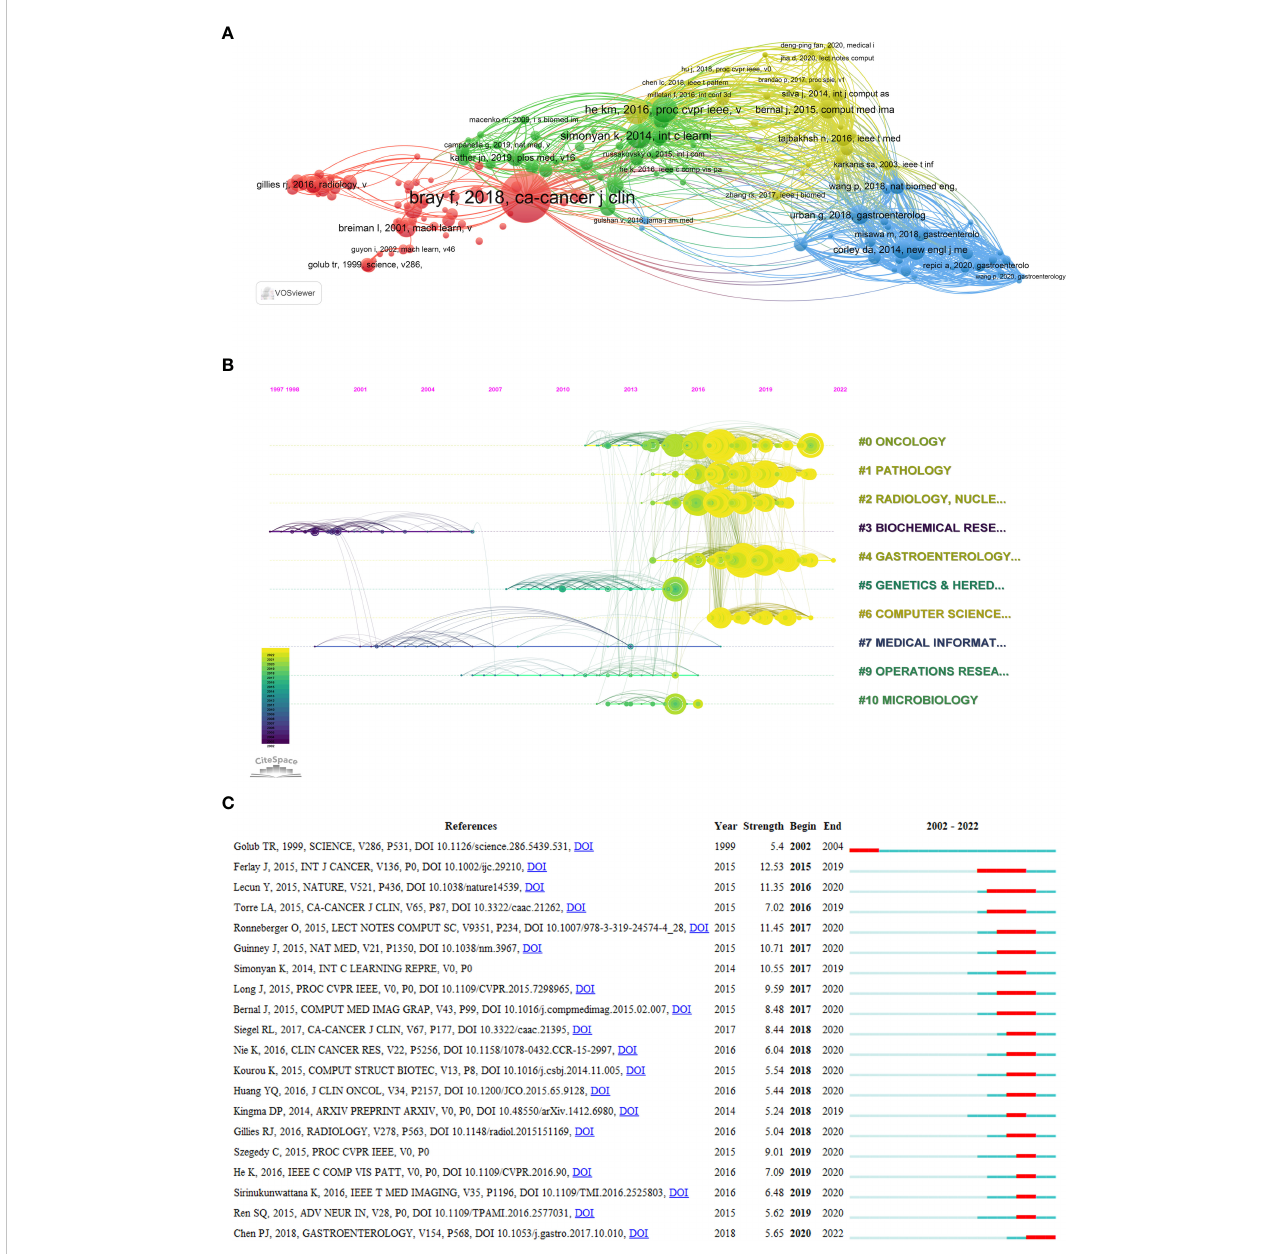
FIGURE 7 Analysis of reference citations (The circle represents the number of citations. The line represents two articles cited by the same article.). (A) Co-citation analysis of references (The colors represent the clustering of references.). (B) Timeline diagram of references (The color represents the average time the reference was cited.). (C) Top 20 references cited in